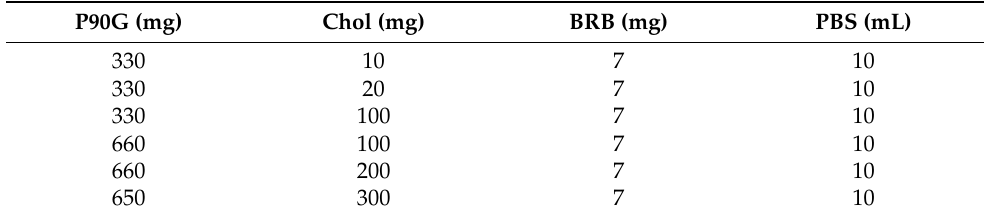
Table 2. Different developed